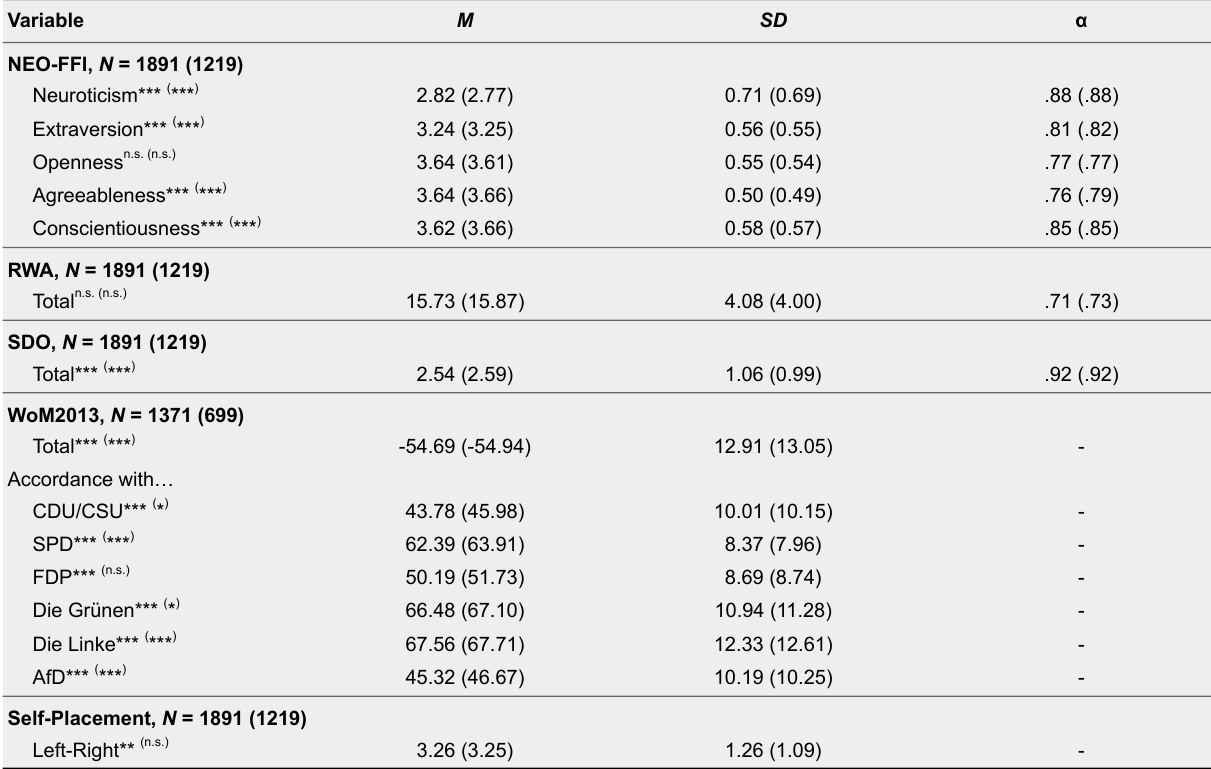
Descriptive Statistics and Internal